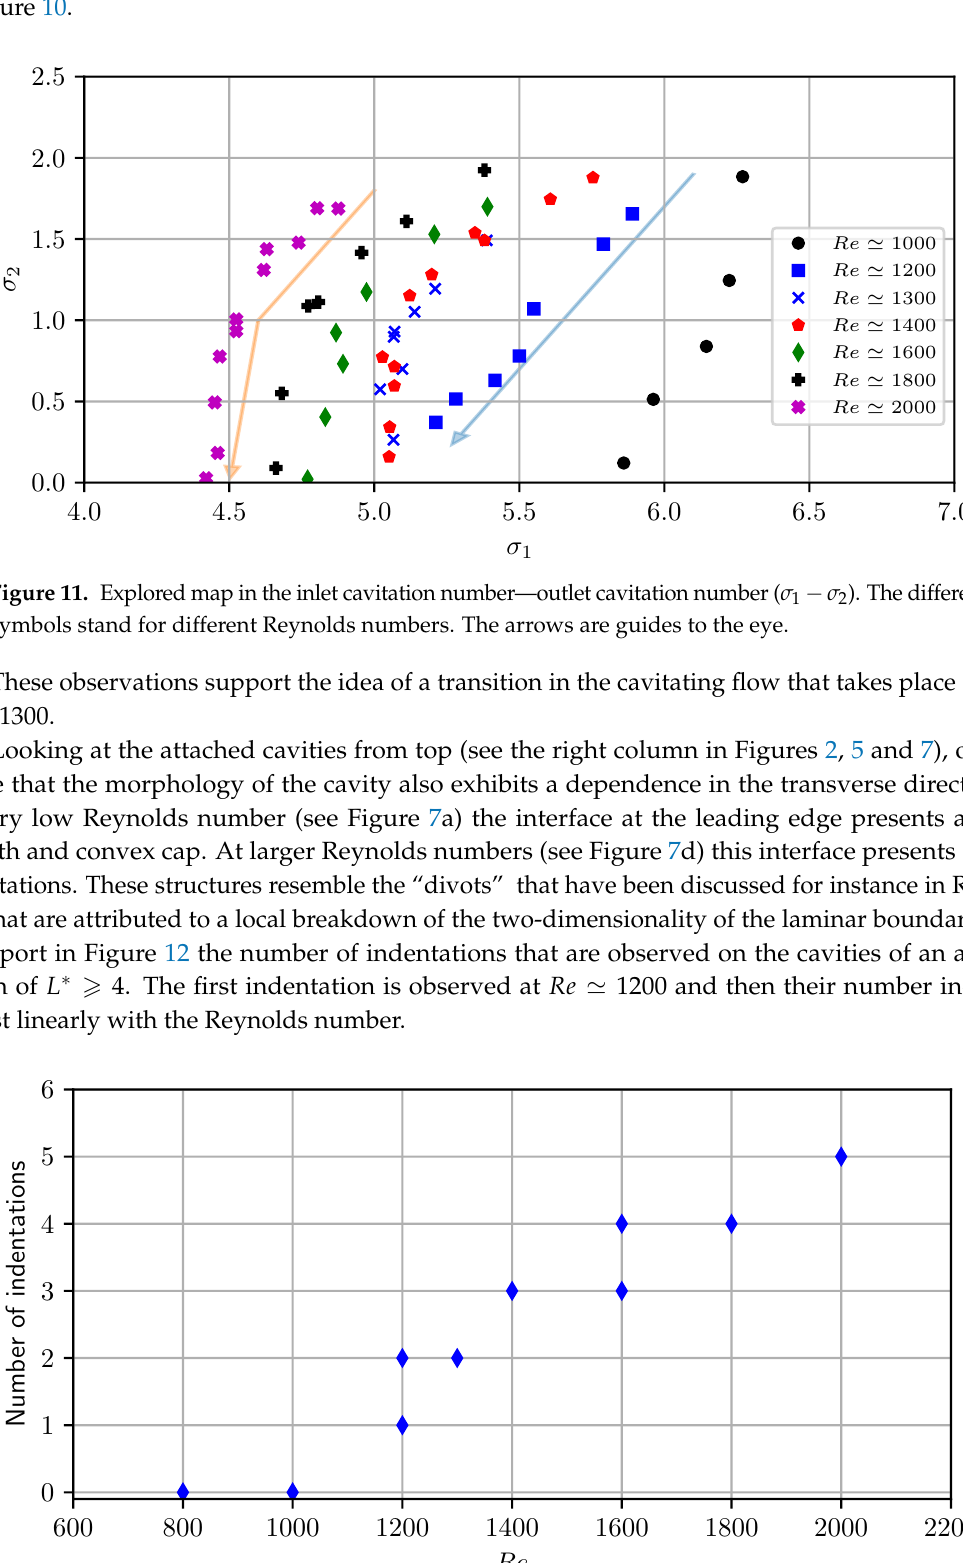
Figure 12. Number of transverse indentations at the leading edge of the developed attached cavities as a function of the Reynolds